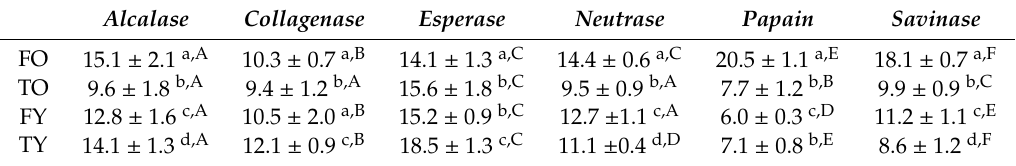
Table 4. Reduction of carbonyls values (%) in 210 mg of meat protein (i.e., 1 g of raw meat), per mg of collagen peptides, at ambient temperature. FO = old femur, 10 years; TO = old tibia, 10 years; FY = young femur, 4.5 years; TY = young tibia, 4.5 years. Alcalase Collagenase